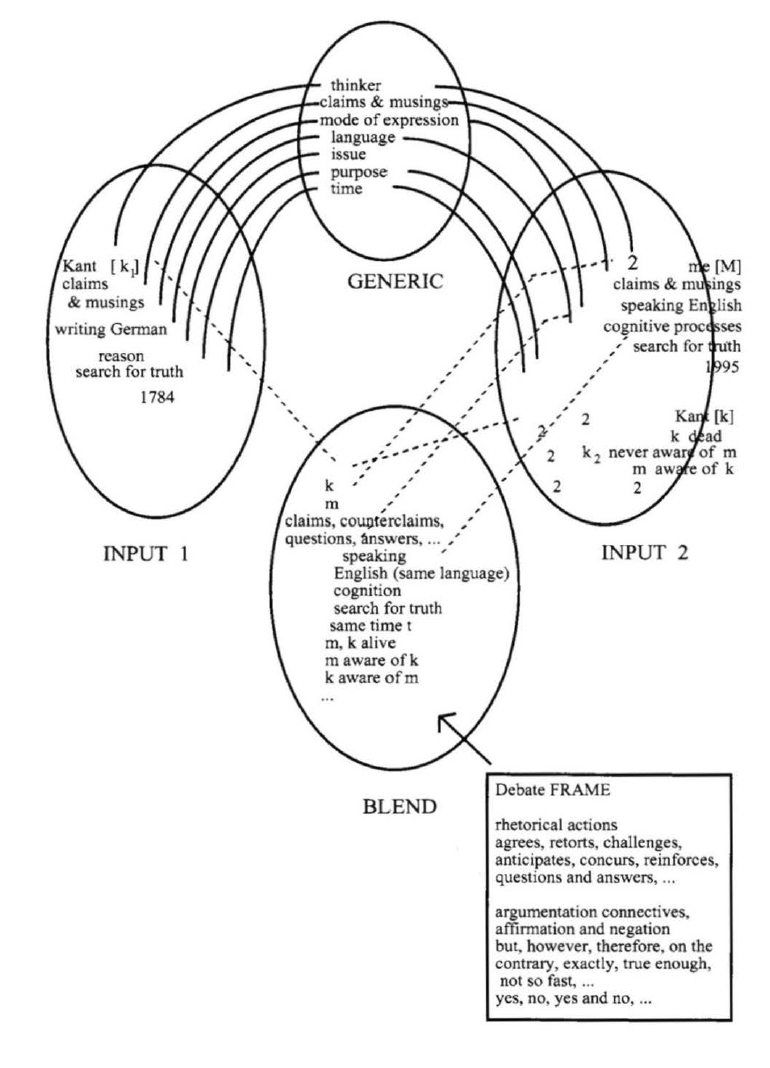
Figure 3: Debate with